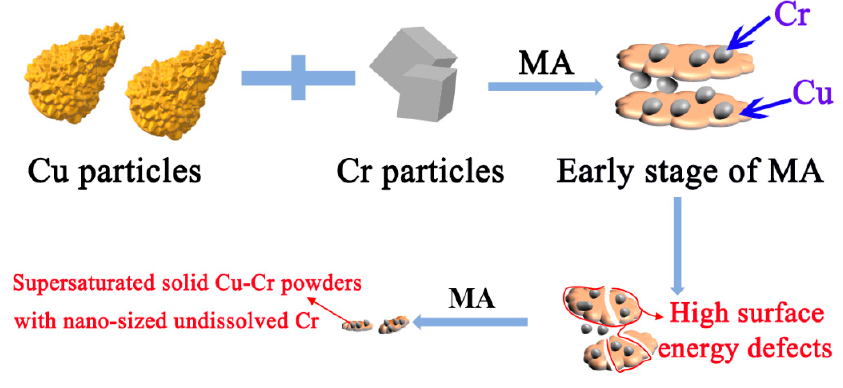
Figure 1. Schematic presentation of morphology changes during mechanical alloying (MA) process average particle size.